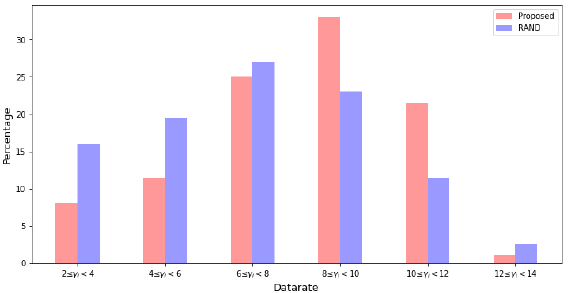
Figure 4. Comparison of the distribution of γ i when | N | =